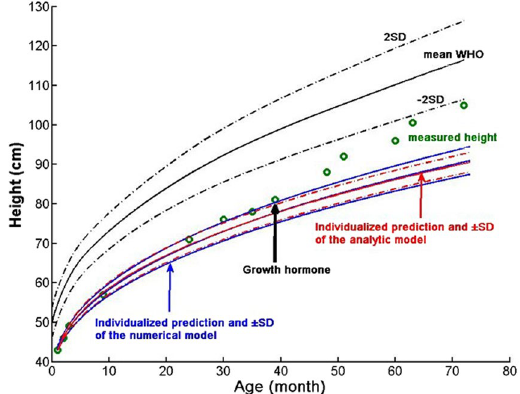
Figure 7. Measured (green circles) and predicted height (blue solid line) and ± SD (blue dashed lines) in a girl born prematurely and small for gestation, following the upper limit of her personal growth trajectory and rapidly exceeding her predicted trajectory after starting growth hormone therapy at the age of 4 years. The WHO mean and ± 2SD curves for girls are also plotted (black). For comparison, the predictions of the analytical model are also shown